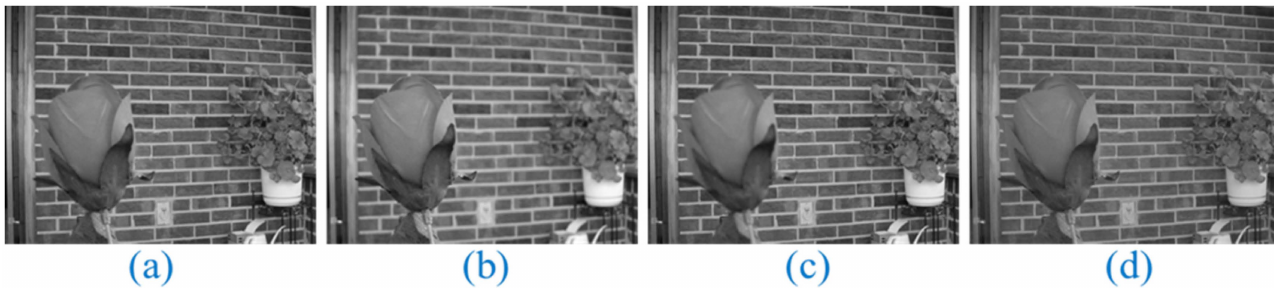
Figure 12. Multi-focus image of a flower from various perspectives. Original Image: ( a ), Multi-focus Input Images: ( b , c ), and Proposed Fusion: ( d